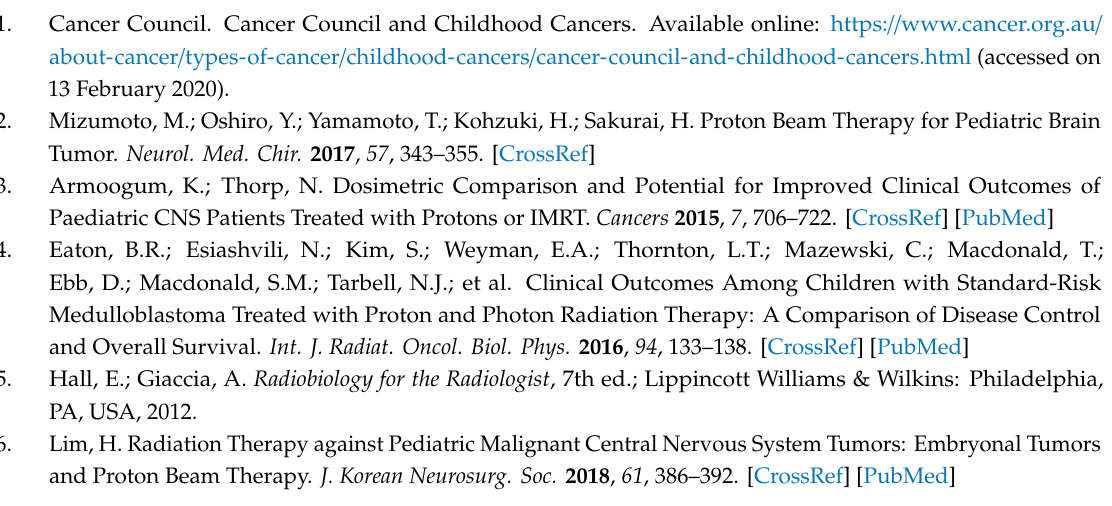
Figure S1: Flowchart of study design, Figure S2: Infratentorial Tumour Location (Medulloblastoma) OAR results- Average dose to optic chiasm across six patients across IMPT and IMRT plans for three MB volumes and locations, Figure S3: Infratentorial Tumour Location (Medulloblastoma) OAR results- Average dose to ipsilateral cochlea across six patients across IMPT and IMRT plans for three MB volumes and locations, Figure S4: Infratentorial Tumour Location (Medulloblastoma) OAR results- Average dose to ipsilateral eye across six patients across IMPT and IMRT plans for three MB volumes and locations, Figure S5: Infratentorial Tumour Location (Medulloblastoma) OAR results- Average dose to ipsilateral lens across six patients across IMPT and IMRT plans for three MB volumes and locations, Figure S6: Infratentorial Tumour Location (Medulloblastoma) OAR results- Average dose to ipsilateral optic nerve across six patients across IMPT and IMRT plans for three MB volumes and locations, Figure S7: Infratentorial Tumour Location (Medulloblastoma) OAR results- Average dose to pituitary gland across six patients across IMPT and IMRT plans for three MB volumes and locations, Figure S8: Supratentorial Tumour Location (Ependymoma) OAR results- Average dose to ipsilateral cochlea across six patients across IMPT and IMRT plans for three STEP volumes and locations, Figure S9: Supratentorial Tumour Location (Ependymoma) OAR results-Average dose to ipsilateral eye across six patients across IMPT and IMRT plans for three STEP volumes and locations, Figure S10: Supratentorial Tumour Location (Ependymoma) OAR results- Average dose to ipsilateral lens across six patients across IMPT and IMRT plans for three STEP volumes and locations, Figure S11: Supratentorial Tumour Location (Ependymoma) OAR results-Average dose to ipsilateral optic nerve across six patients across IMPT and IMRT plans for three STEP volumes and locations, Figure S12: Supratentorial Tumour Location (Ependymoma) OAR results- Average dose to pituitary gland across six patients across IMPT and IMRT plans for three STEP volumes and locations, Figure S13: 13-year-old male head position for CT simulation compared to the rest of the cohort, Figure S14: Ipsilateral eye, lens and optic nerve sparing across IMPT (left) and IMRT (right) plans for STEP clinical volumes in 13-year-old female patient, Table S1: The absolute dose ranges for IMPT (Gy(RBE)) plans (grey shading) and IMRT (Gy) plans (white) for critical structures averaged across 6 patient plans collected for supratentorial ependymoma (prescribed dose 54 Gy / Gy(RBE)) , Table S2: The absolute dose ranges for IMPT (Gy(RBE)) plans (grey shading) and IMRT (Gy) plans (white) for critical structures averaged across 6 patient plans collected for infratentorial medulloblastoma (prescribed dose of 54 Gy / Gy(RBE) (23.4 Gy / Gy(RBE) craniospinal irradiation with 30.6 Gy / Gy(RBE) boost)), Table S3: Summary of T-test observations comparing significant di ff erences between IMPT and IMRT plans for a range of structures and their respectively collected DVH metrics (maximum, mean, median and D10), Table S4: Mean and D10 dose di ff erence ( ∆ IMRT (Gy)-IMPT (Gy(RBE))) for critical structures across 3 patient ages and location (volumes averaged). Prescribed dose for both tumour sites was 54 Gy / Gy(RBE) (23.4 Gy / Gy(RBE) craniospinal irradiation with 30.6 Gy / Gy(RBE) boost for